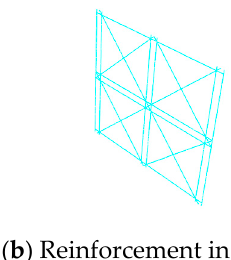
Figure 14. Mesh generation of latticed concrete wall specimen with diagonal bracing.